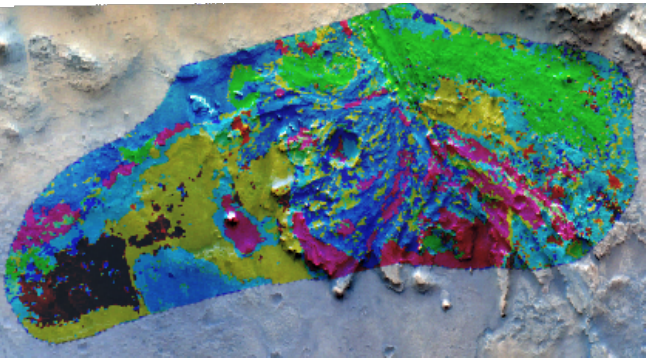
Figure 5. Spectral cluster map by UMAP-k-Means and 6 clusters for the complete clustered area of Jezero